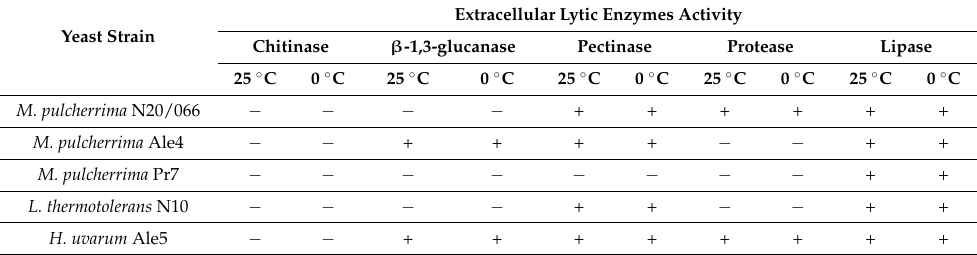
Table 1. Extracellular lytic enzymes activity of yeast strains. The symbol (+) indicates that the isolate was able to hydrolyze the compound; the symbol (–) indicates that the isolates were not able to hydrolyze the